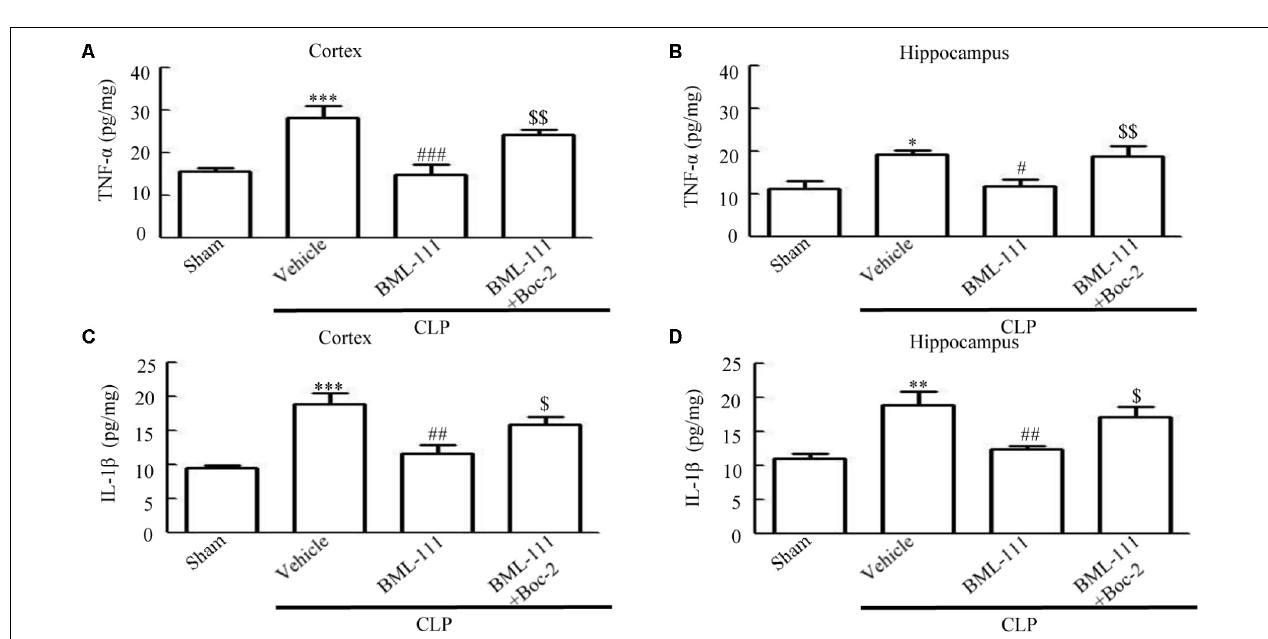
FIGURE 6 | BML-111 treatment reduces the activation of astrocyte in mice with sepsis. (A,B) CLP up-regulated the GFAP-positive cells significantly compared with the sham group. BML-111 treatment decreased the number of positive cells compared with the CLP + vehicle group, and Boc-2 reduced the effects of BML-111. Scale bars indicate 50 µ m ( n = 3 surviving mice per group per experiment). Data were shown as the means ± SEM. ∗∗ P < 0.01, ∗∗∗ P < 0.001 represent CLP + Vehicle vs. Sham, ## P < 0.01, ### P < 0.001 represent CLP + BML-111 vs. CLP + Vehicle, $$ P < 0.01, $$$ P < 0.001 represent CLP + BML-111 + Boc-2 vs. CLP + BML-111.